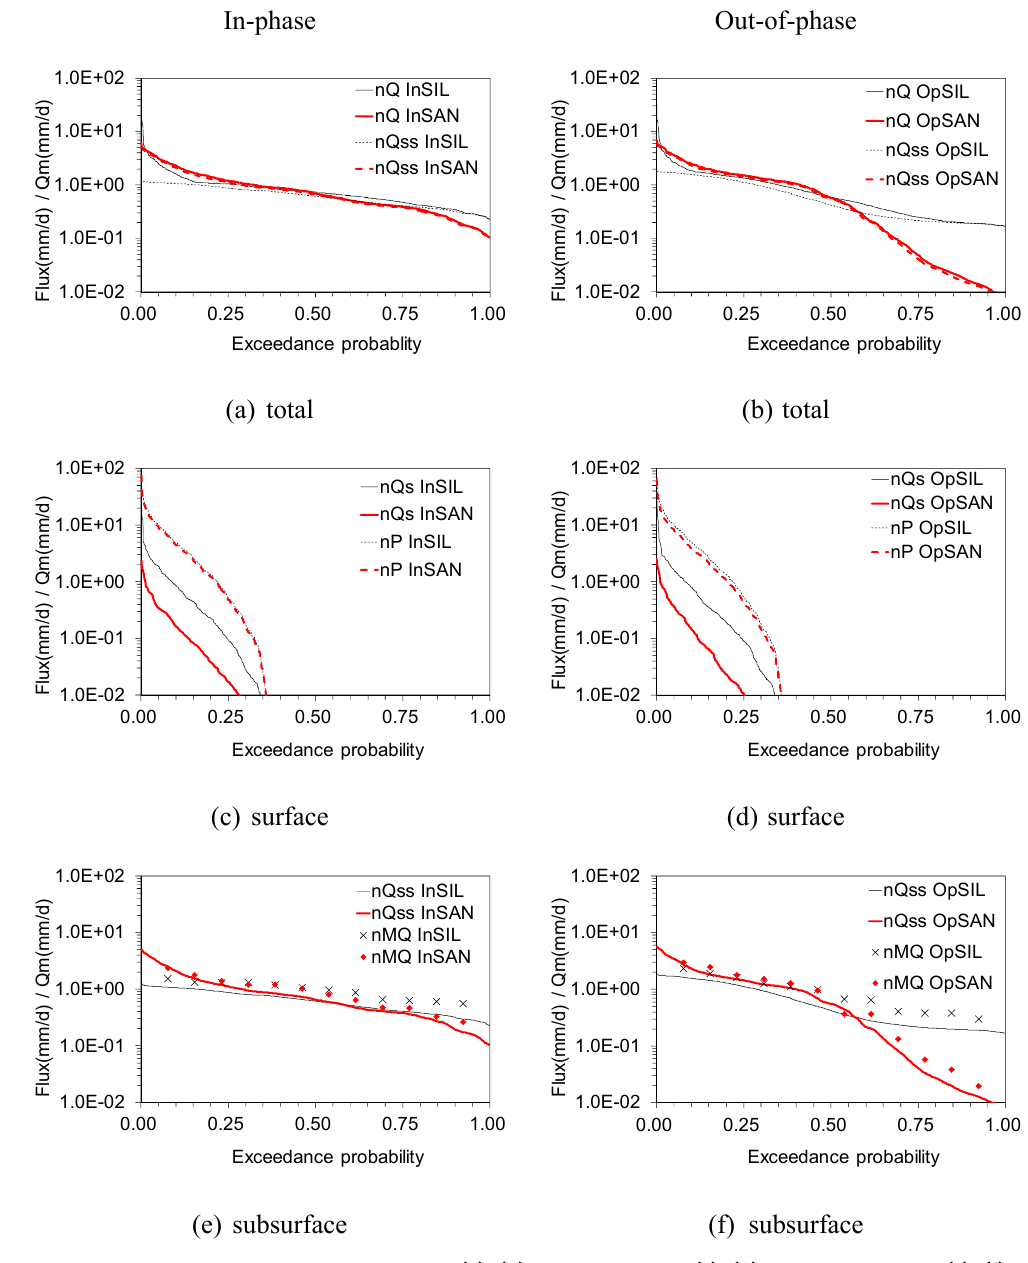
Fig. 4. Effect of soil type for different climatic seasonality: (a) , (b) : Total flow FDC, (c) , (d) : surface flow FDC, (e) , (f) : subsurface flow FDC. (a) , (c) , (e) : seasonal peaks of P and PET are in phase, (b) , (d) , (f) : seasonal peaks of P and PET are of opposite phase. “SAL” and “SAN” indicate silty loam and sand. Q m is mean annual daily flow (mmd − 1 ). “ nMQ ” refers to FDC associated with the regime curve – ensemble averaged mean within-year daily variation normalized by mean annual daily flow Q m . Default value of climate dryness is R =0.5 (humid), soil depth is 8m and a topographic gradient is